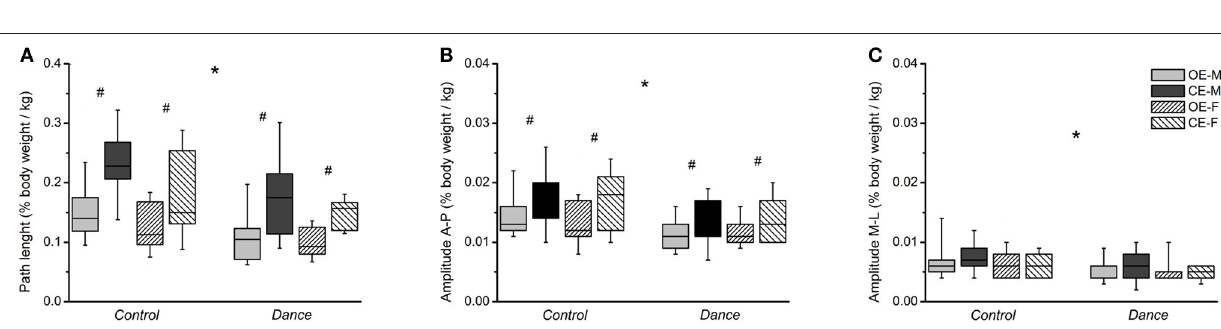
and the anteroposterior sway amplitude of CoP ( p < 0.001, = 0.339) across the groups ( Figure 2 ). However, there was η 2 p no significant effect of vision on the mediolateral amplitude of CoP ( p = 0.439, Figure 2 ). No significant vision-by- group interaction was also found for either path length ( p = 0.463) or anteroposterior ( p = 0.237) and mediolateral sway amplitudes ( p = 0.74) ( Figure 2 ). Furthermore, there examined CoP balance parameters (path length, p = 0.125; anteroposterior amplitude, p = 0.794; mediolateral amplitude, p = 0.129) ( Figure 2 ). Likewise, no significant vision-by-group- by-sex interaction was found for either path length ( p = 0.84) or anteroposterior ( p = 0.499) and mediolateral sway amplitudes ( p = 0.814) ( Figure 2